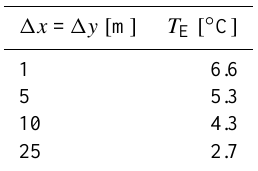
Table 1. The effective temperature in the single cell at the source in case of the point-like continuous discharge located at point Z =(1850, 775) for different sizes of grid cell. 1x = 1y [ m ]